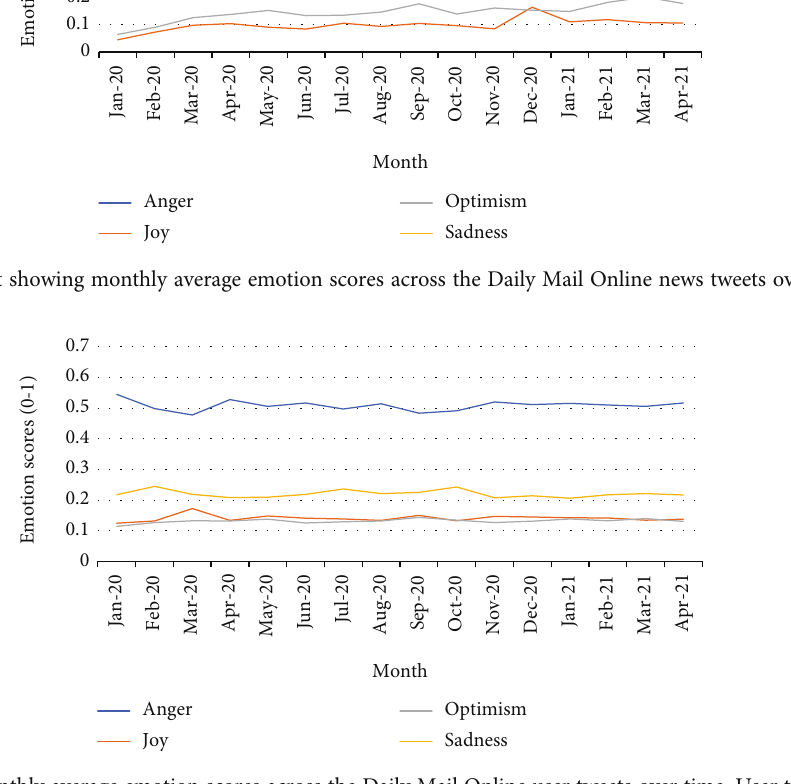
Figure 8: Chart showing monthly average emotion scores across the Daily Mail Online user tweets over time. User tweets are reactions to the Daily Mail Online news tweets shown in Figure